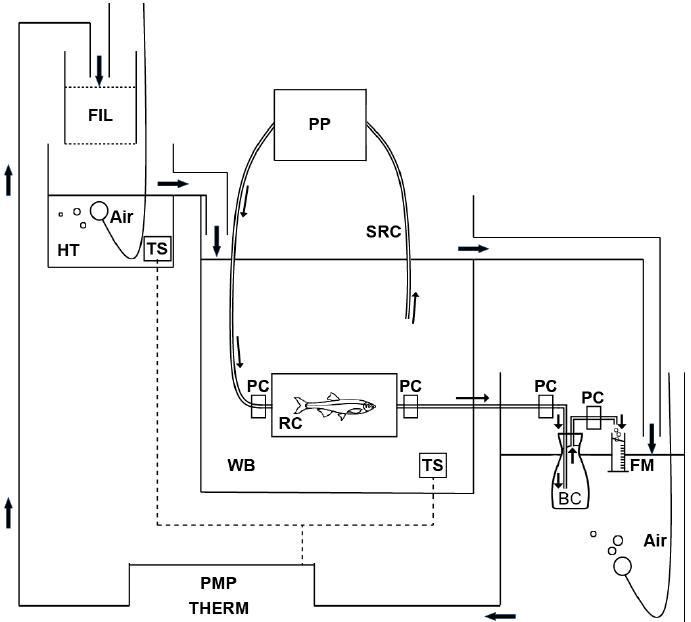
Figure 1. Diagram showing the micro-semi-closed method equipped with the peristalic pump. BC, blank changer; FIL, filter; FM, flow meter; HT, head tank; PC, pinchcock to close the RC and BC; PMP, pump; PP, peristaltic pumps; RC, respiration chamber; SRT, silicone rubber tube; THERM, thermostat; TS, temperature sensor; WB, water bath.